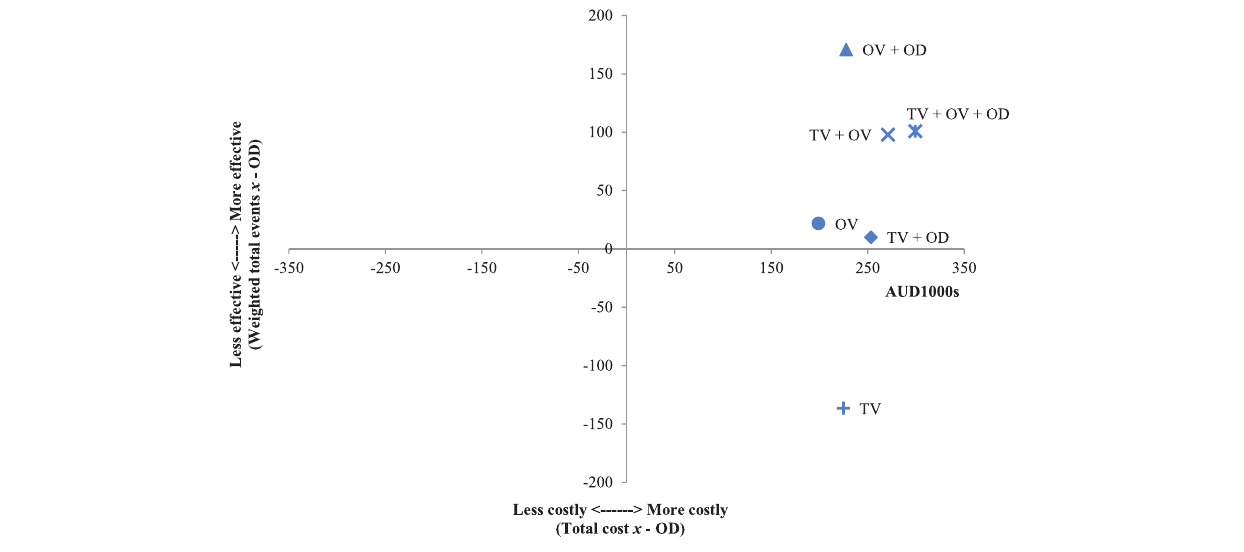
FiguRE 3 | Incremental cost-effectiveness of each format compared with online display (OD). The cost-effectiveness of OD forms the baseline (cross-section of x and y axes). Effectiveness is weighted total events of each format ( x ) compared with OD. Cost is total costs in AUD1,000s of each format ( x ) compared with OD. Data points that fall in the upper left quadrant represent formats that are more cost-effective than